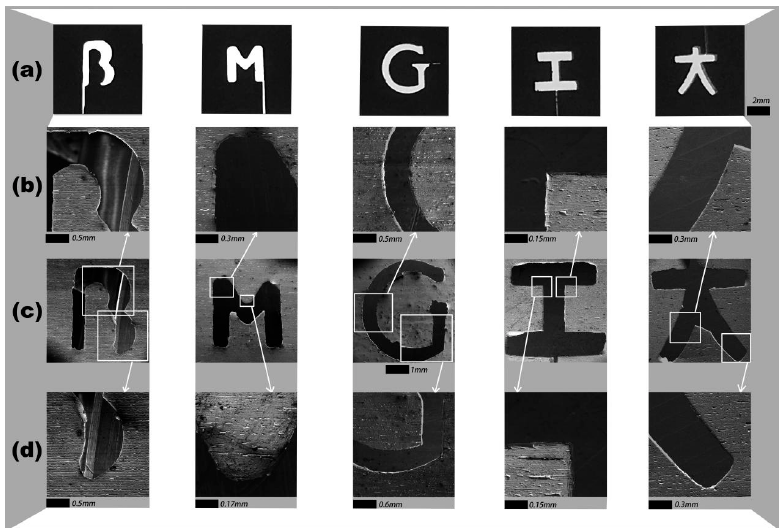
Figure 2. ( a ) Low-speed wire electric discharge machining mold cavity. ( b , d ) The partial magnified SEM image of the products. ( c ) SEM image of a product of amorphous alloy formed after shear punching of amorphous alloys under high-frequency vibrations. The proportions are all 1 mm.